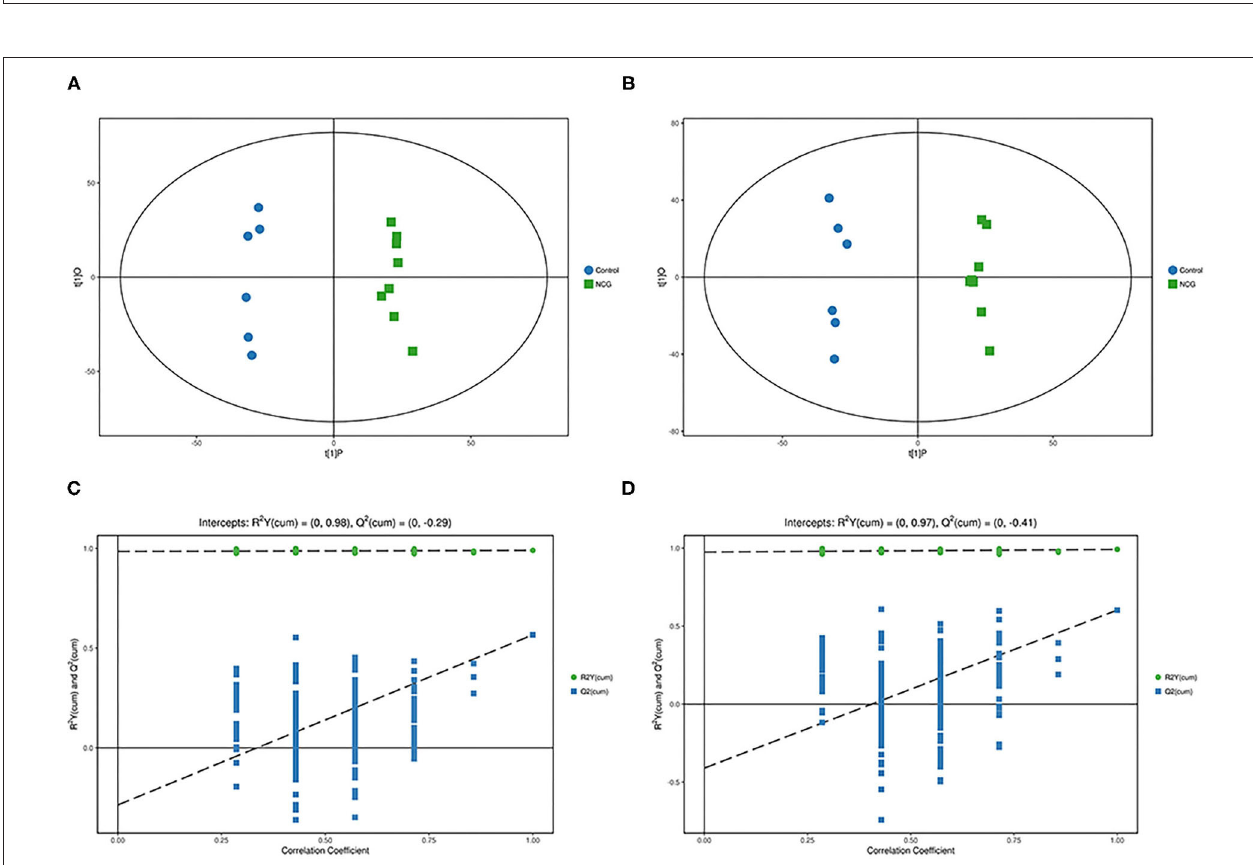
FIGURE 3 | (A) Principal component analysis score plot for the NCG group and CON group plasma samples analyzed in the positive ion mode. (B) Principal component analysis score plot for the NCG and CON group samples analyzed in the negative ion mode. The abscissa PC[1] = first principal component and the ordinate PC[2] = second principal component. The blue circle represents the CON group, and the green square represents the NCG group. The samples are all in within the 95% confidence interval (Hotelling’s T-squared ellipse). The blue circle represents the diet without NCG supplementation (Control, CON group, N = 6), and the green box represents the experimental group with 20 (g/d7head) NCG added to the diet (NCG, NCG group, N = 8).